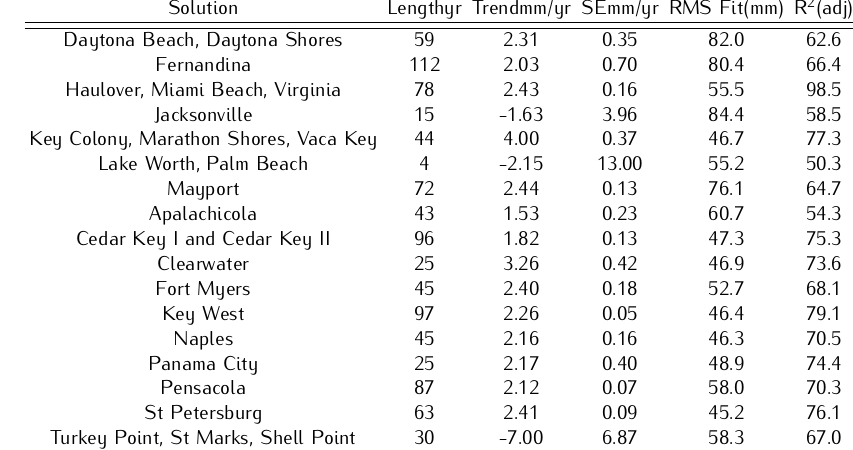
Table 1. Solution statistics for the estimates of the MSL trends from the 26 stations tide gauge data. A number of tide gauge data from very close stations as indicated in the table’s solution entries are combined in the local solution in a single series. Local solutions for these data sets take into account the reference level differences. SE stands for Standard Error of the estimate. RMS fit is the root mean square of the residuals.